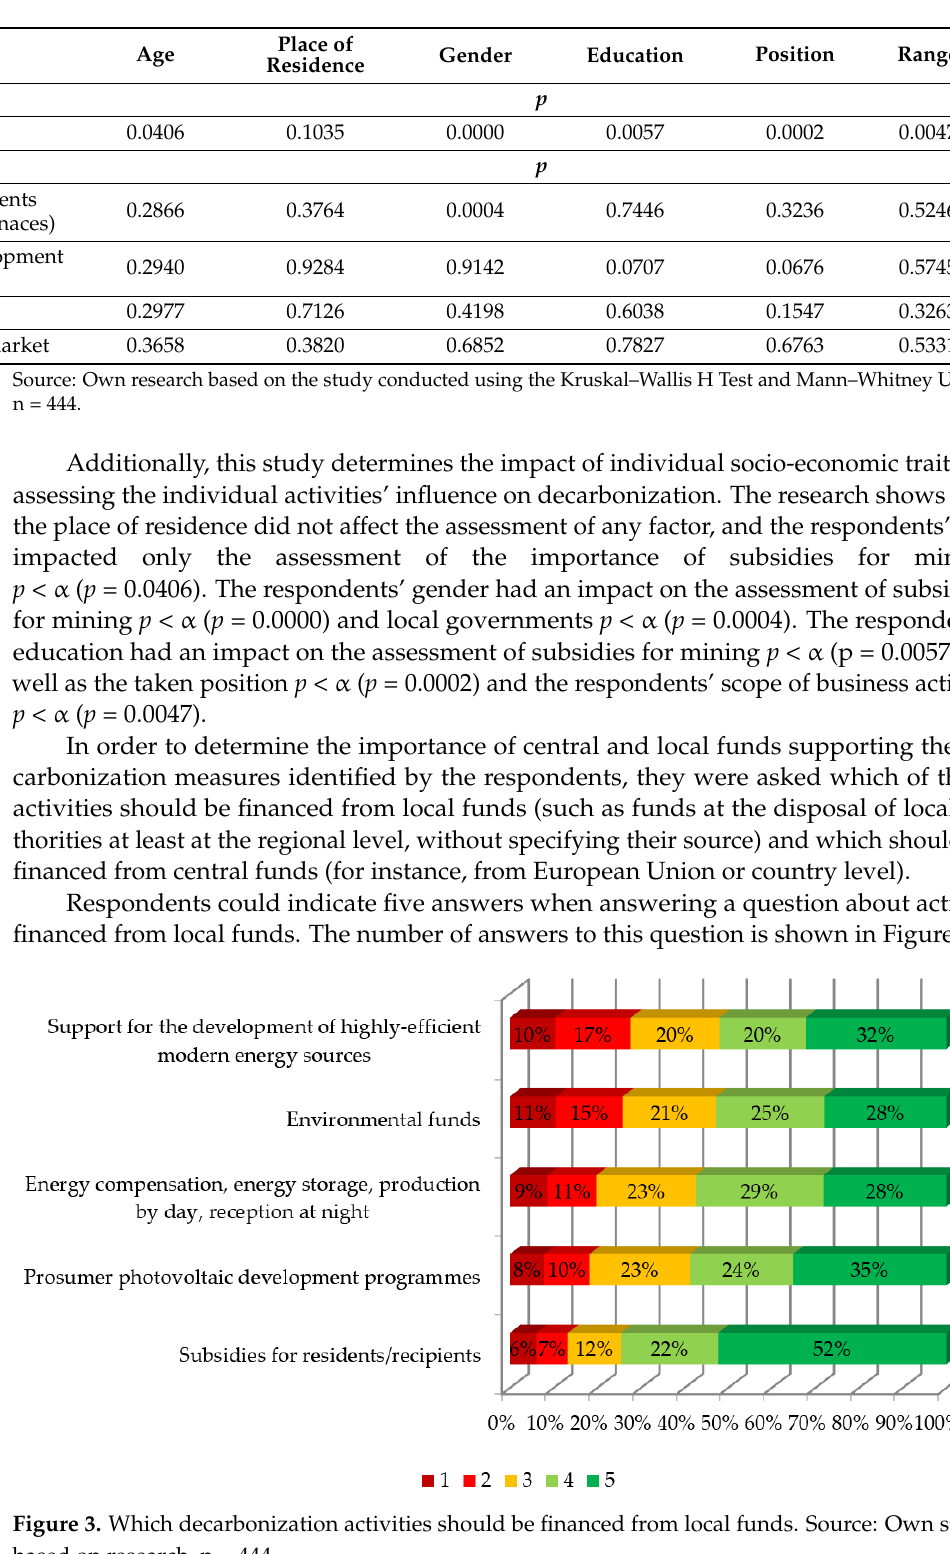
Table 3. Selection of individual decarbonization activities by respondents and their socio-economic characteristics.